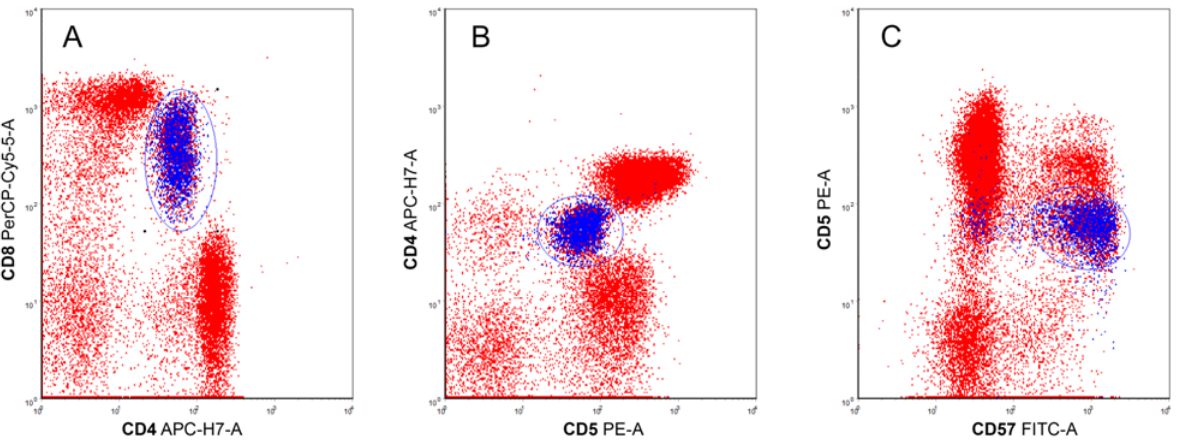
Figure 1. Case #20. Flow cytometry of T-cell large granular lymphocytic leukemia in peripheral blood shows ( A ) CD4low/CD8low (depicted in blue), ( B ) CD4low/CD5low (depicted in blue), and ( C ) CD5low/CD57+ (depicted in blue) expression. Cytotoxic (CD3+/CD8low or CD3+/CD8+) T-lymphocytes coexpressed CD57+ in 16 (80%) of 20 cases and CD16 in 6 (32%) of 19 cases. Diminished (or absent) membrane ex- pression of CD5 on CD8low/+ lymphocytes was detected in 18 (90%) of 20 cases. Overall, phenotypic abnormalities characteristic for T-LGL leukemia were detected in 19 of the 20 studied patients. Evaluation for T-cell receptor ( TCR ) genes rearrangement was investigated in all 21 patients: in peripheral blood in 20 patients, and in spleen tissue in 1 patient. Monoclonal rearrangement of TCR genes was detected in 20 patients (in 19 patients in peripheral blood and in 1 patient in spleen tissue), and polyclonal rearrangement of TCR genes was observed in 1 patient, in the peripheral blood. In the cohort of T-LGL leukemia with SS, STAT3 mutations were found in 12 (57%) patients: in 1 patient with pSS and in 11 patients with sSS. Mutational hot spots included D661Y in seven cases; N647I in three cases; and Y640F, S614R, D661V, K658R, N664T, and S614G in one case each (Figure 2). Three out of the twelve patients had more than one STAT3 mutation.